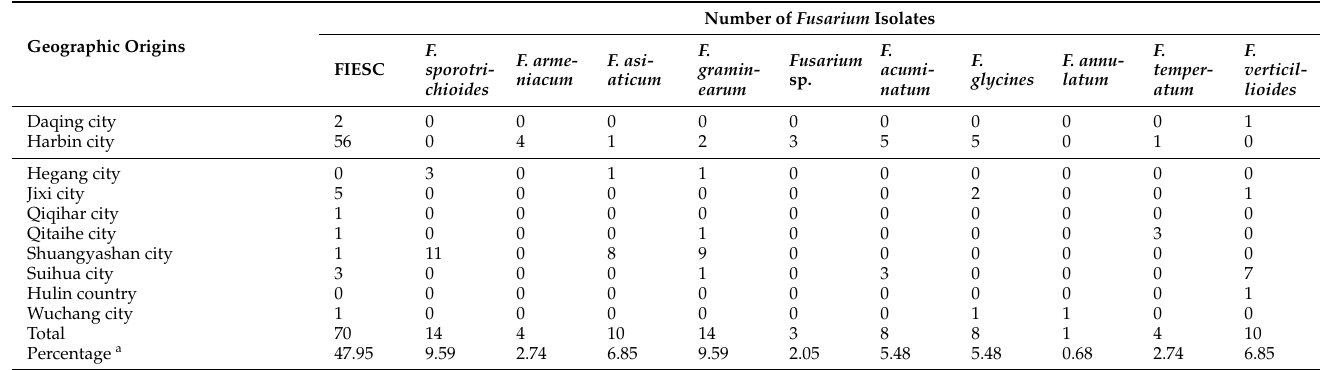
Table 2. Geographic origins and number of Fusarium isolates recovered from symptomatic maize leaves with macroscopic symptoms of leaf blight collected from 10 locations in Heilongjiang province, China.